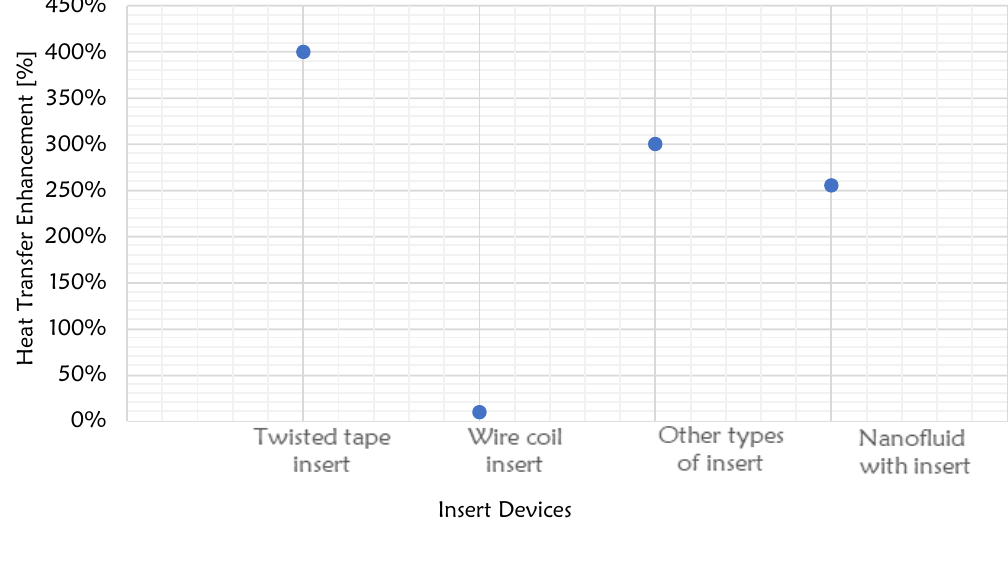
Figure 20: Comparative representation of heat transfer enhancement by classified